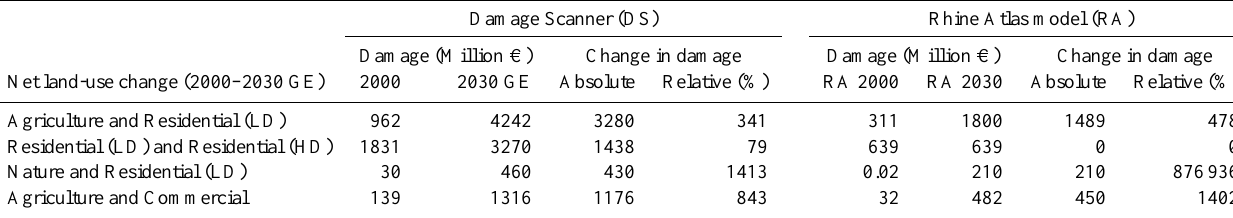
Table 7. Specific effect of important changes among land-use types in terms of potential flood damage for the two models.